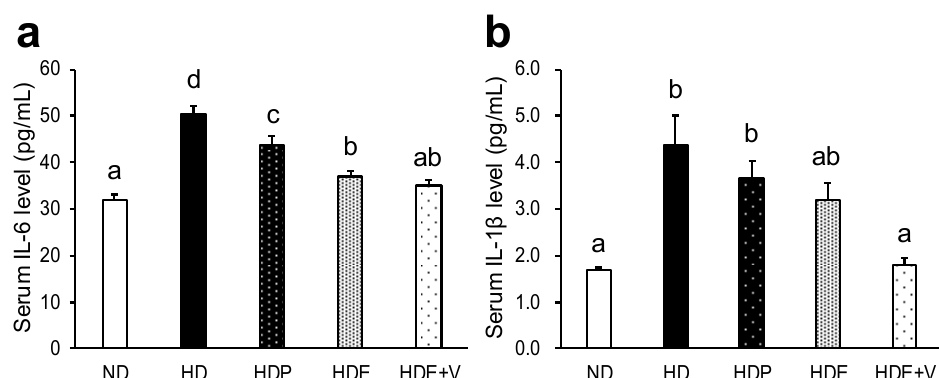
Figure 2. Effects of the intake of Euglena and vegetables on inflammation parameters in diet-induced obese mice. ( a ) Serum IL-6 level and ( b ) Serum IL-1 β level are presented as the mean ± standard error of the mean, n = 10. a,b,c Different superscript letters indicate significantly different means at p < 0.05 (refer to “Result” in detail). ND, a group fed the normal diet; HD, a group fed the high-fat diet; HDP, a group fed the high-fat diet containing 0.3% paramylon; HDE, a group fed the high-fat diet containing 1.0% Euglena; HDE + V, a group fed the high-fat diet containing 1.0% Euglena and 0.3% vegetables. Table 5. Biochemical parameter in serum and liver.